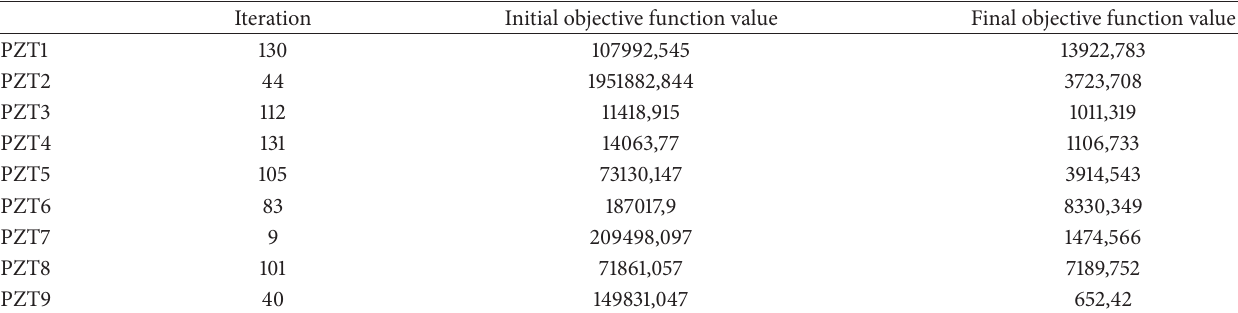
Table 7: Optimization results of the Gustafson-Kessel algorithm for the aircraft